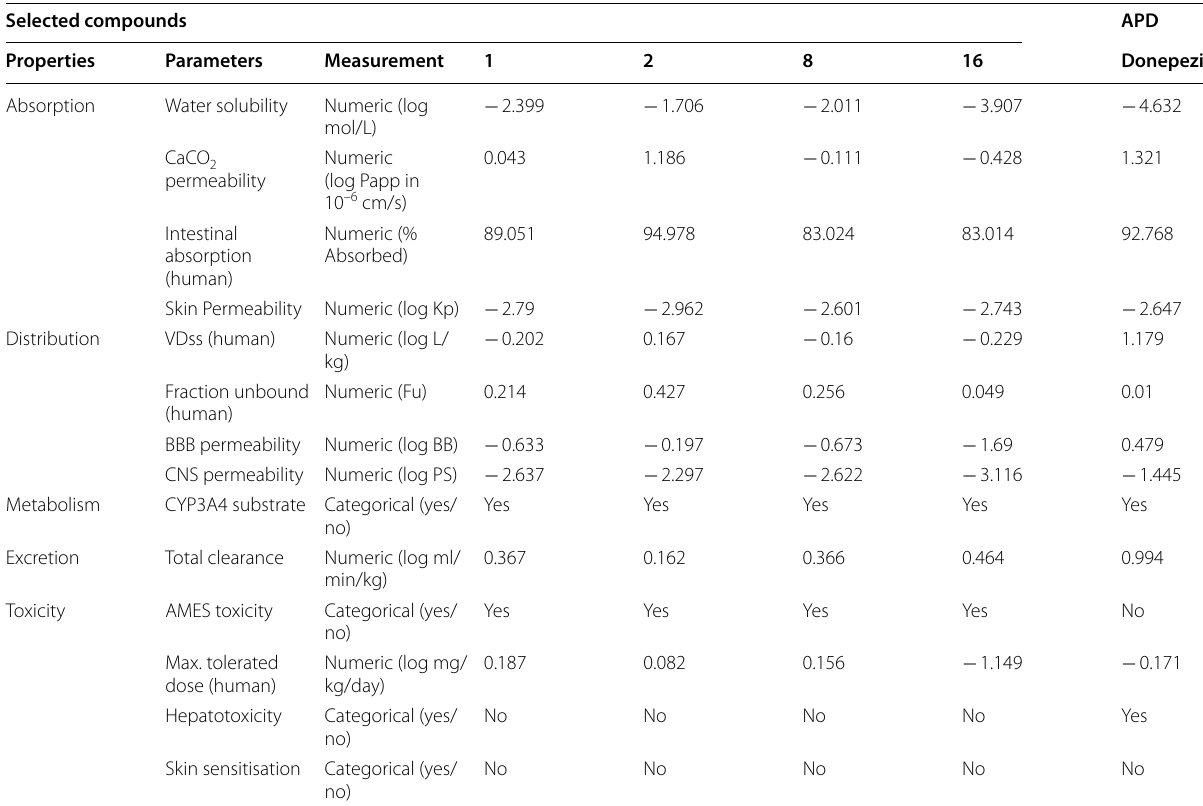
Table 4 ADMET/Pharmacokinetics properties of selected ligands with highest binding affinity Selected